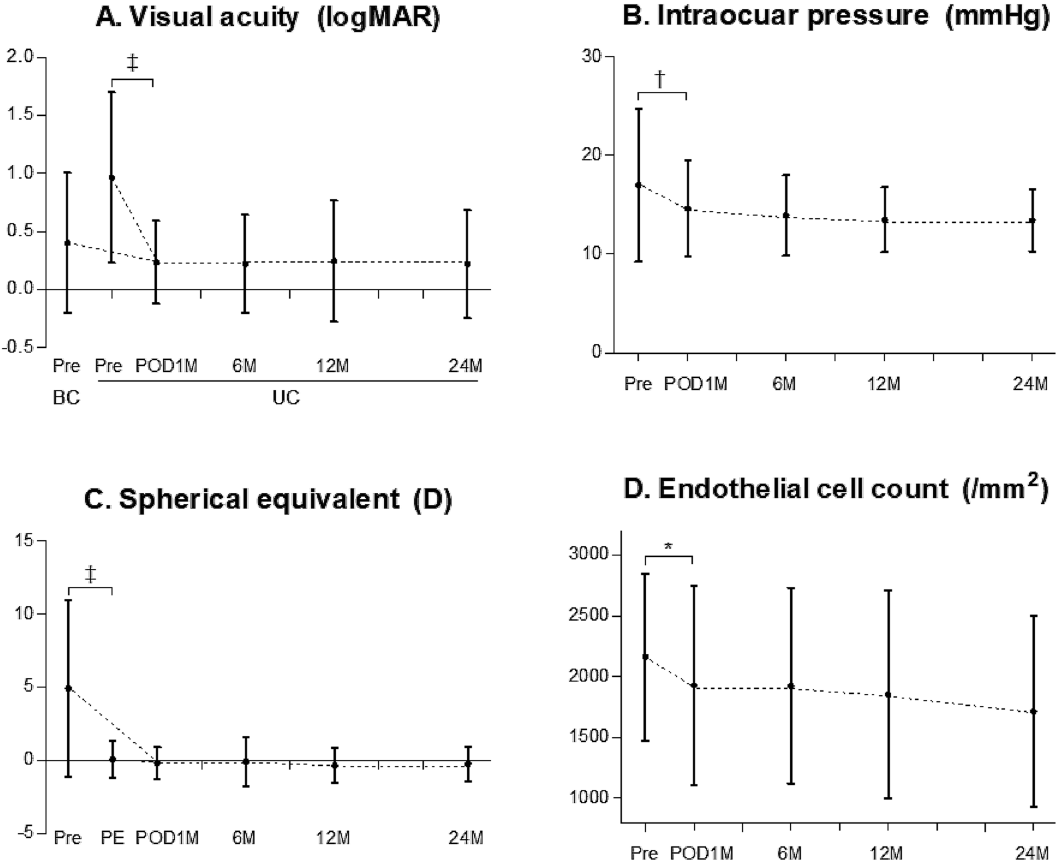
Figure 2. Changes in ( A ) visual acuity, ( B ) intraocular pressure, ( C ) spherical equivalent, and (D) endothelial cell count before and after retropupillary iris claw intraocular lens implantation for the treatment of intraocular lens dislocation. LogMAR, logarithm of the minimum angle of resolution; Pre, preoperative; POD, postoperative days; M, month; BC, best-corrected; UC, uncorrected; D, diopter; PE, prediction error. Repeated measures analysis of variance with post-hoc Fisher’s LSD test for statistical analysis was performed (* P < 0.05, † P < 0.01, ‡ P < 0.001). The small black dots represent mean data points and error bars represent standard deviations.